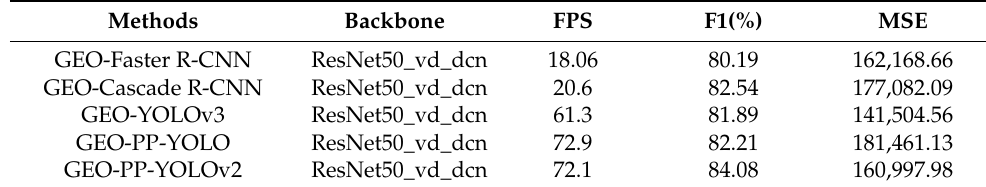
Table 2. Performance comparison of different 2D single-frame object detectors.